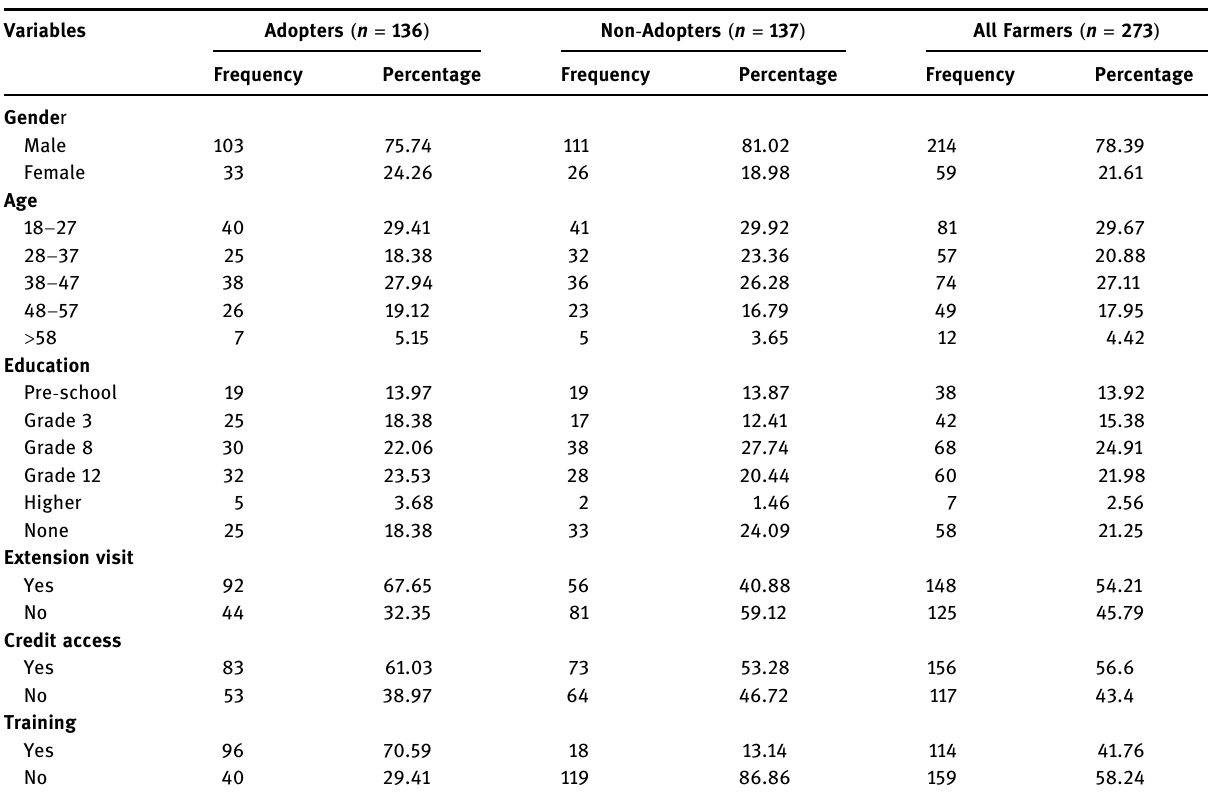
Table 2: Demographic characteristics of the farmers ( N = 273 ) Variables Adopters ( n = 136 )